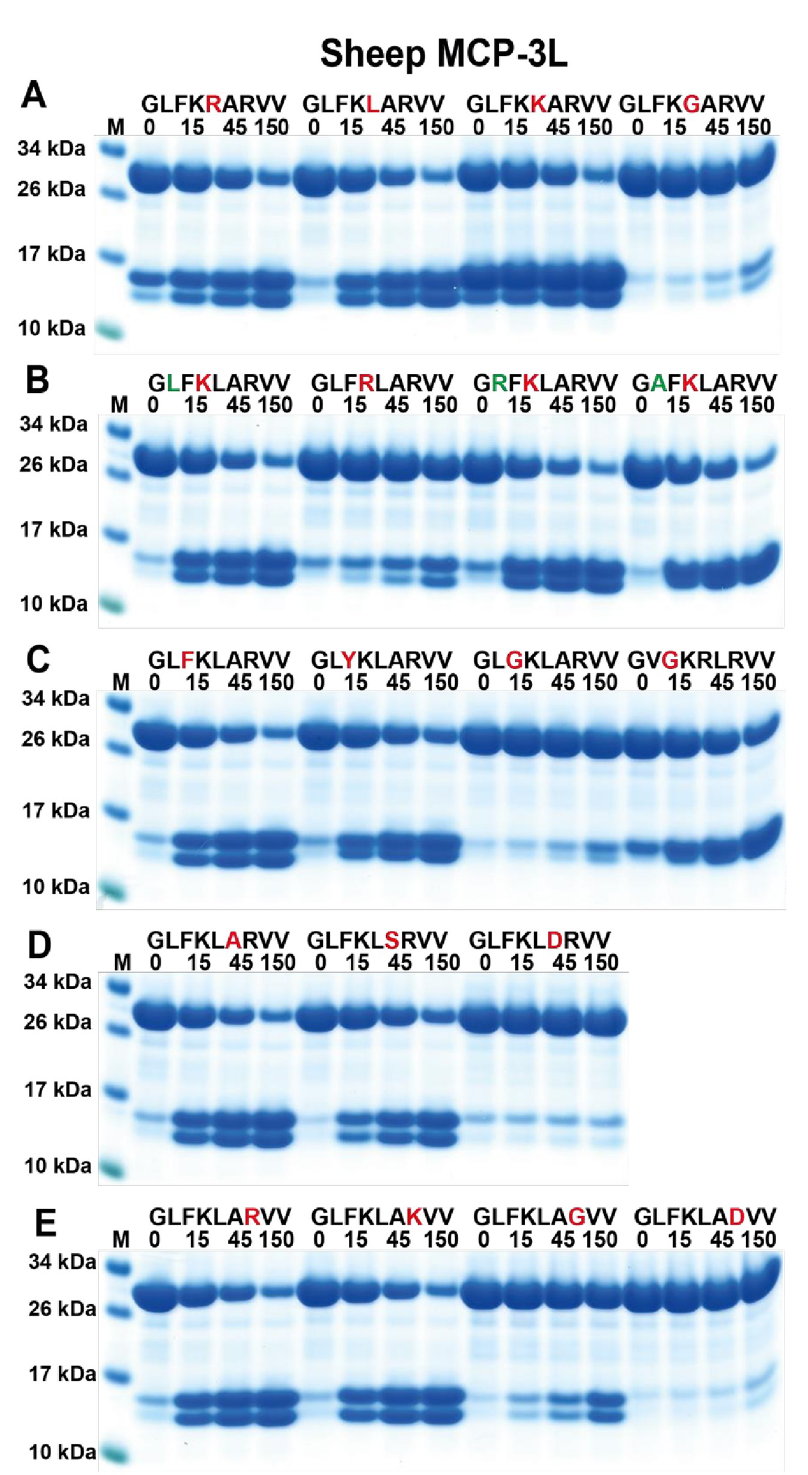
Fig 9. Verification of the cleavage specificity of sheep MCP3-like using recombinant protein substrates. Panels A to E show the cleavage of several substrates by MCP3-like. The sequences of the different substrates are indicated above the pictures of the gels. The time of cleavage in minutes is also indicated above the corresponding lanes of the different gels. The uncleaved substrates have a molecular weight of ~25 kDa and the cleaved substrates appear as two closely located bands with a size of 12–13 kDa. Residues of particular interest and that may differ between different substrates are marked in red or green for an easy identification.